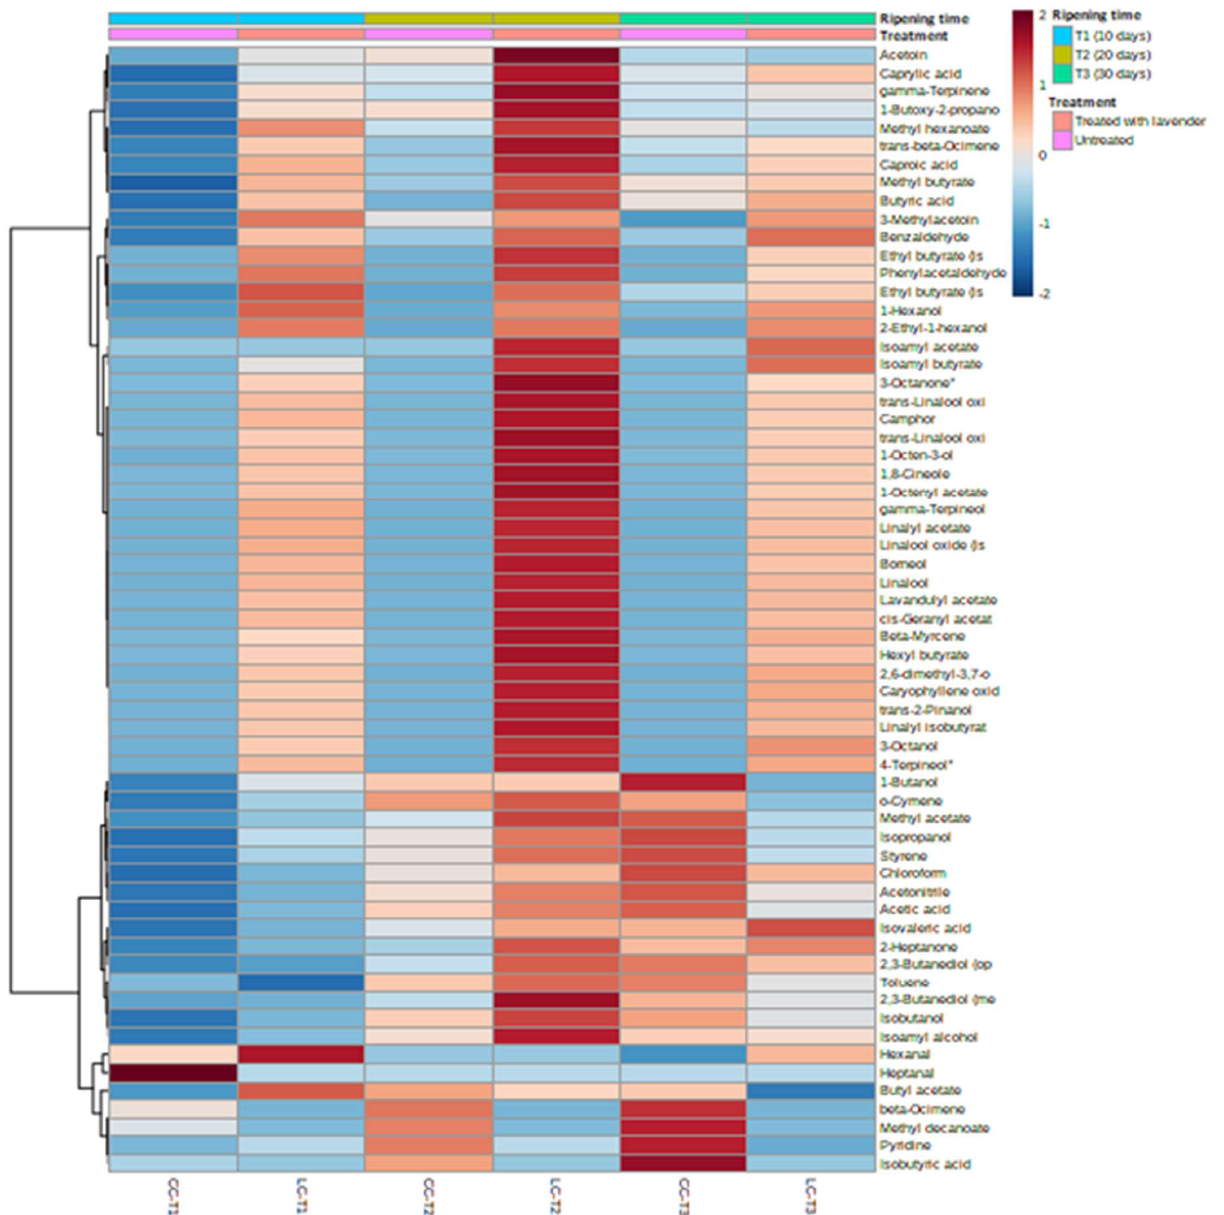
Figure 3. HCA heatmap of Gouda-type cheese based on volatile constituents.